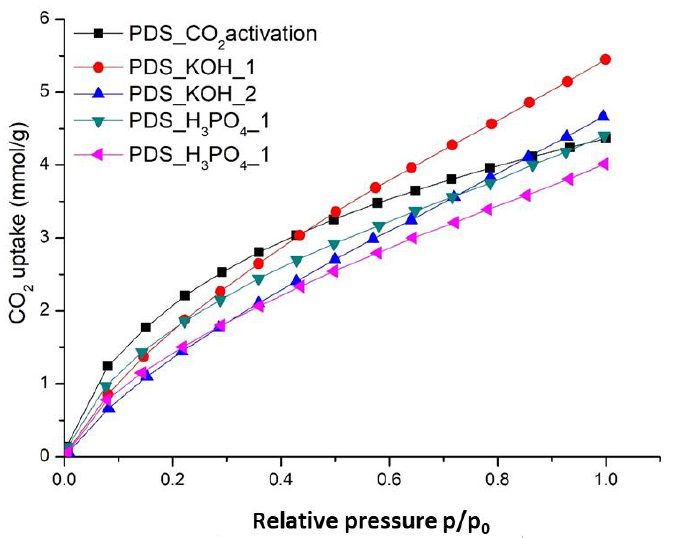
Figure 4. Pure component CO 2 adsorption isotherms, measured at 25 °C and up to 1 bar, of the activated HTC-PDS powders.